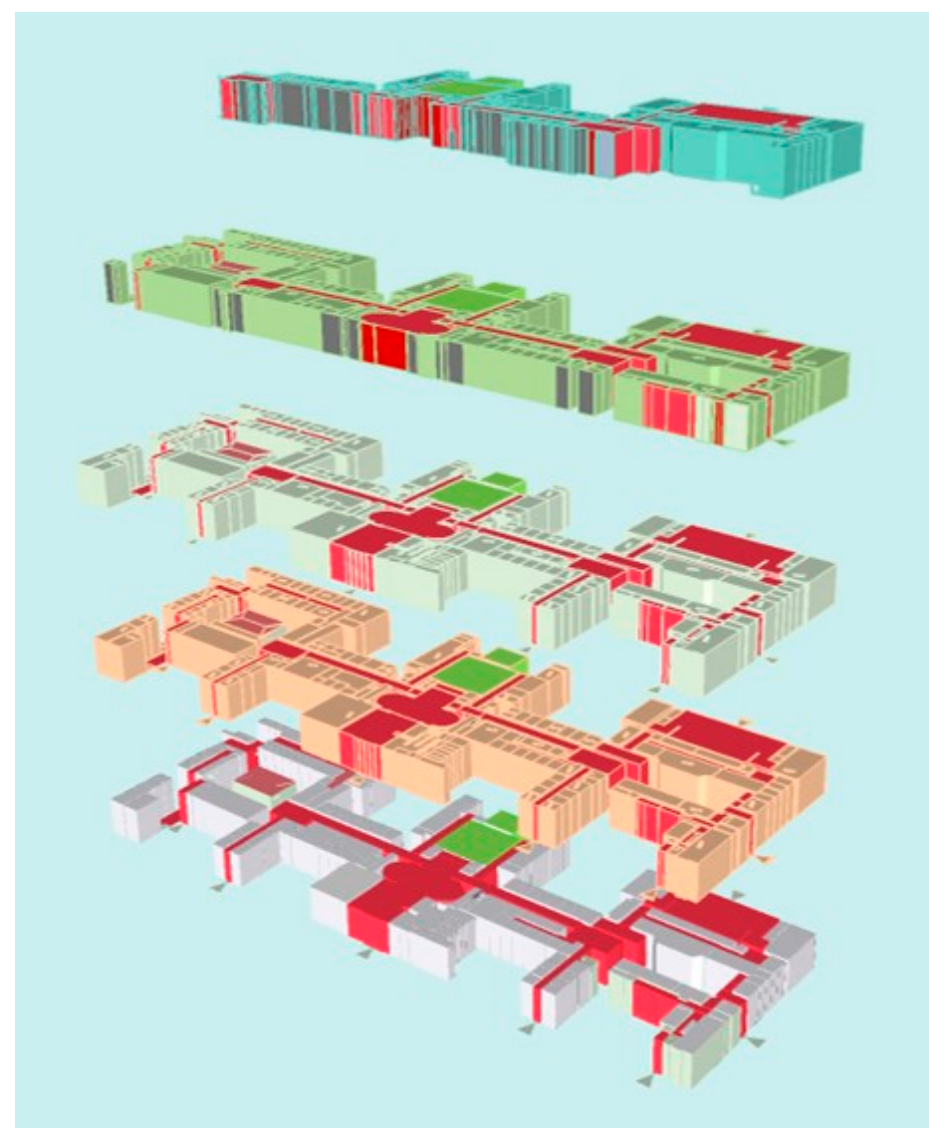
Figure 2. Geometric changes of indoor spaces during the lifetime of a building for complex buildings for the Technical University of Munich (TUM). Campus 3D map-rendered corridors [29].